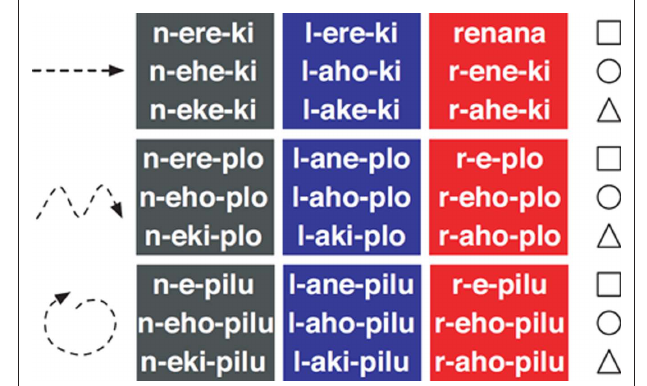
4 Interestingly, they note that positional number codes have only emerged in recent times (e.g., unknown to the Romans), perhaps because they are conceptually chal-